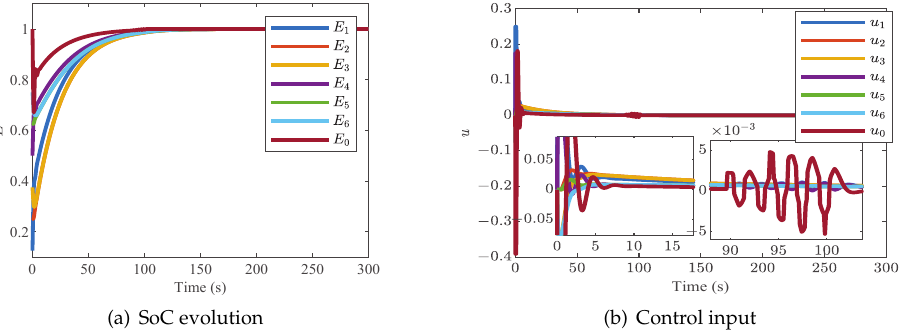
Figure 8. The SoC evolution and control input under the input time delay τ = 0.1 in the distributed charging strategy with a WE-based smart leader in Case